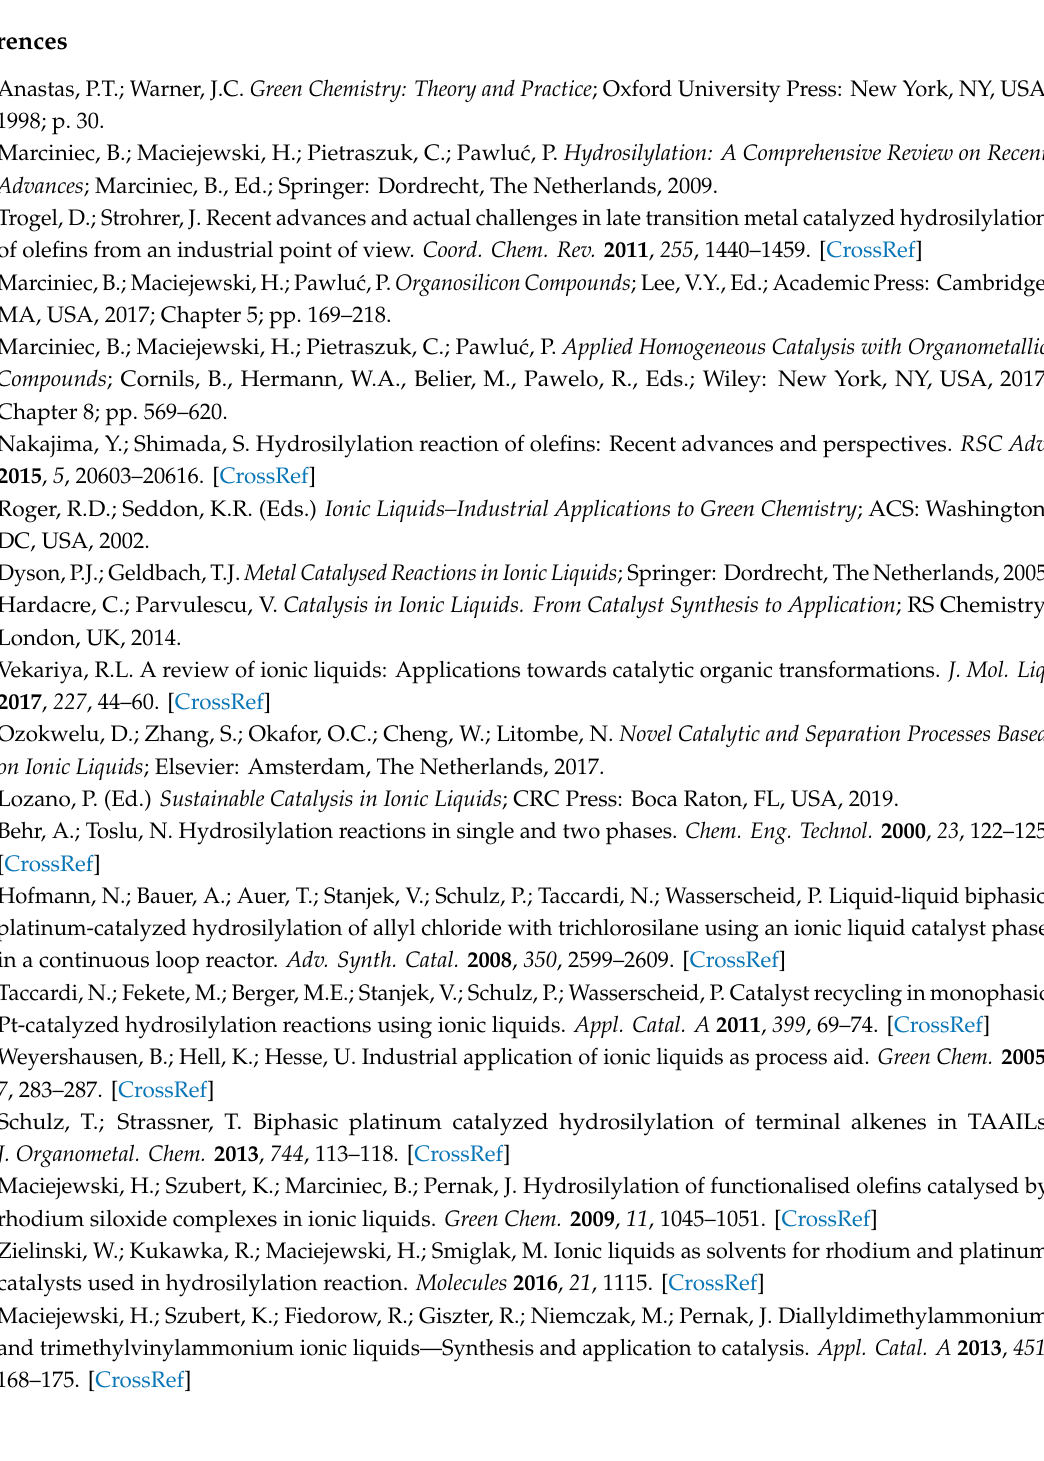
Figure S1–Figure S12: NMR Spectra of complexes, Figure S13–Figure S20: ESI-MS spectra of complexes, Figure S21–Figure S26: NMR spectra of isolated